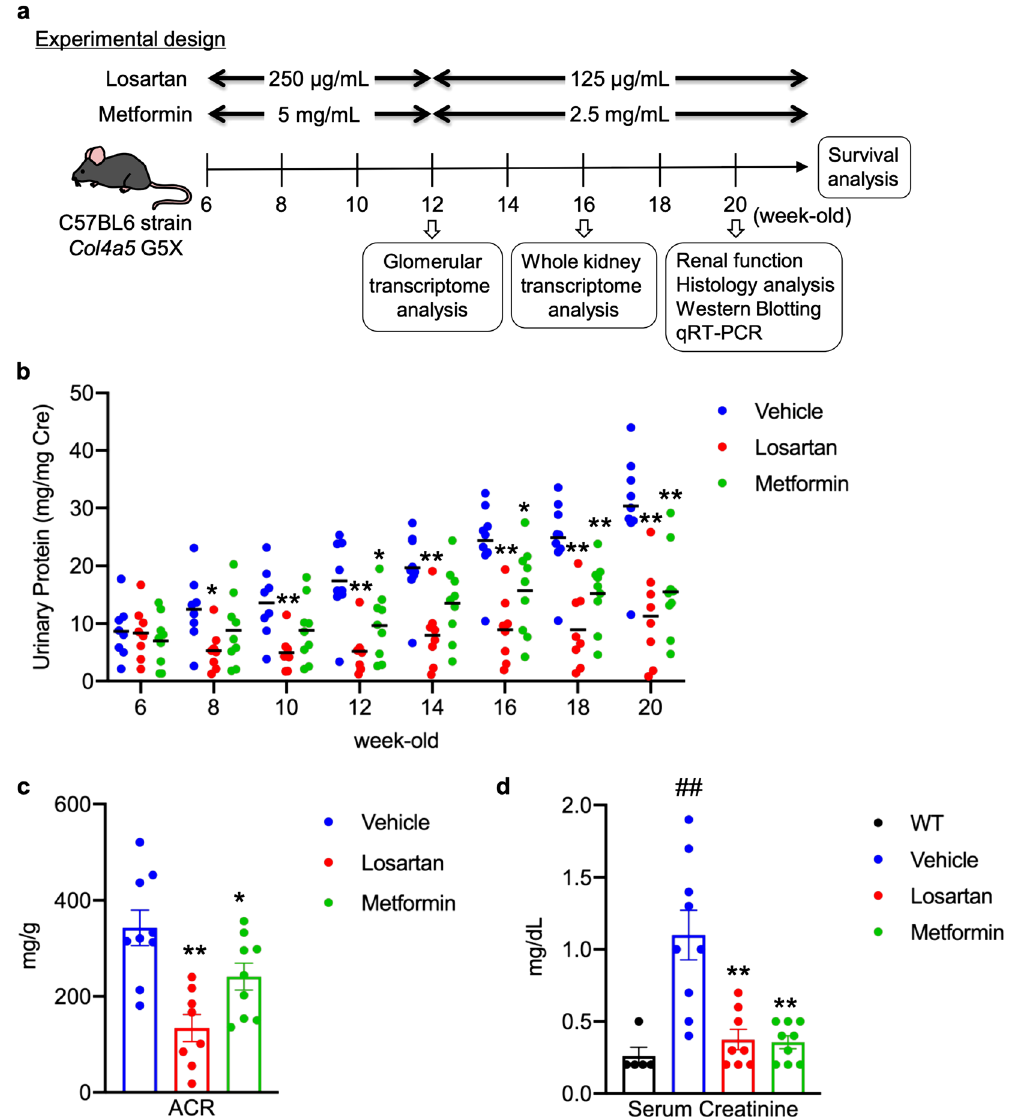
Figure 1. Metformin protects against progressive renal dysfunction in Col4a5 G5X Alport syndrome mice. ( a ) The experimental design of studies performed on C57BL/6 Col4a5 G5X Alport syndrome mice is shown. The image was drawn by S.K. ( b ) Proteinuria score was calculated based on urinary protein and creatinine concentrations. Proteinuria was reduced in losartan or metformin-treated C57BL/6 Col4a5 G5X Alport syndrome mice. ( c ) Creatinine-normalized urinary albumin concentration was reduced in losartan- or metformin-treated C57BL/6 Col4a5 G5X Alport syndrome mice. ( d ) The elevation of serum creatinine level in late stage C57BL/6 Col4a5 G5X Alport syndrome mice was suppressed by losartan or metformin treatment. Data are expressed as the means ± S.E. in WT (n = 5), vehicle-, losartan- or metformin-treated C57BL/6 Col4a5 G5X Alport syndrome mice (n = 8–9 per group). P values were assessed by Dunnett’s test ( ## P < 0.01 vs WT. * P < 0.05, ** P < 0.01 vs